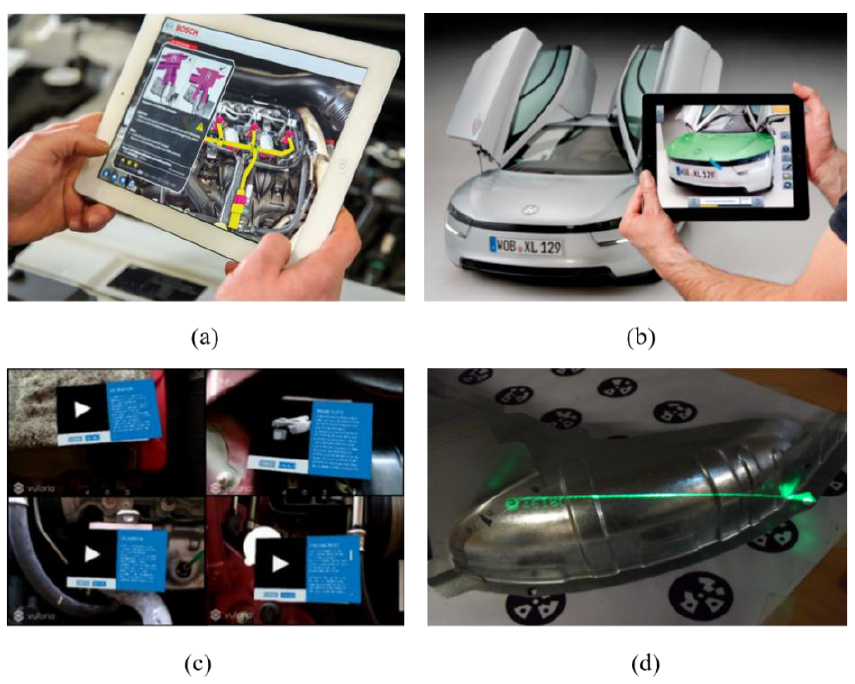
Figure 1. Examples of AR application assisted inspection for: ( a ) Bosh industry [25], ( b ) Volkswagen industry [22], ( c ) under hood inspection [23], ( d ) Spot Welding inspection